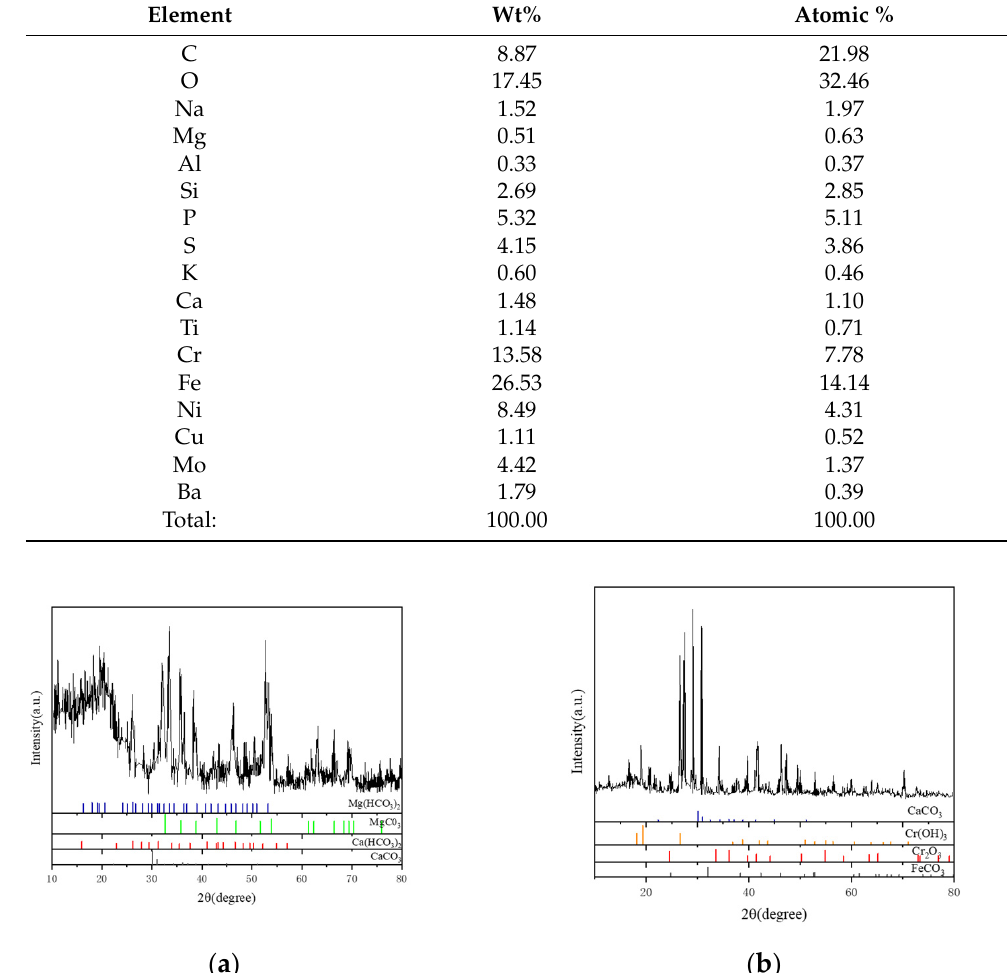
Figure 9. Section Energy Spectrum Analysis Diagram of Corrosion Scale Layer (EDS Surface Scan). Table 2. Content of O, C, Na, Mg, Al, Si, P, S, K, Ca, etc. in the Dense Scale Layer.